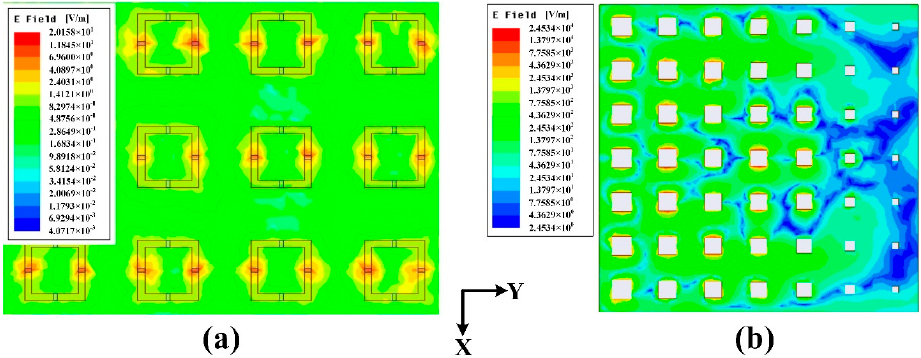
Figure 14. Surface E-field plots. ( a ) Absorber surface for VP incident wave. ( b ) Gradient surface.